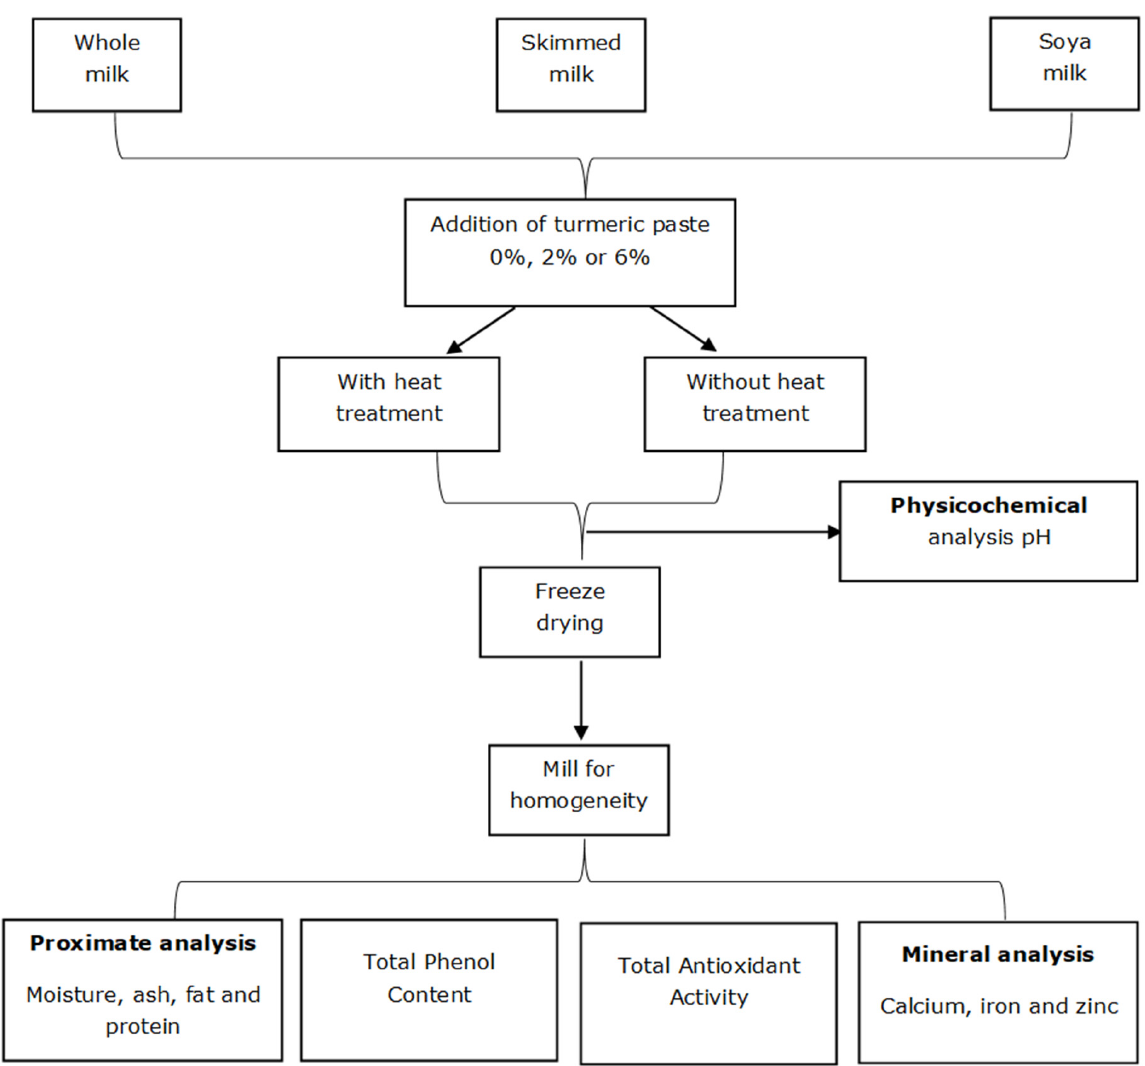
Figure 2. Schematic diagram of the preparation of the turmeric-fortified cow and soya milk samples with the subsequent laboratory analyses.